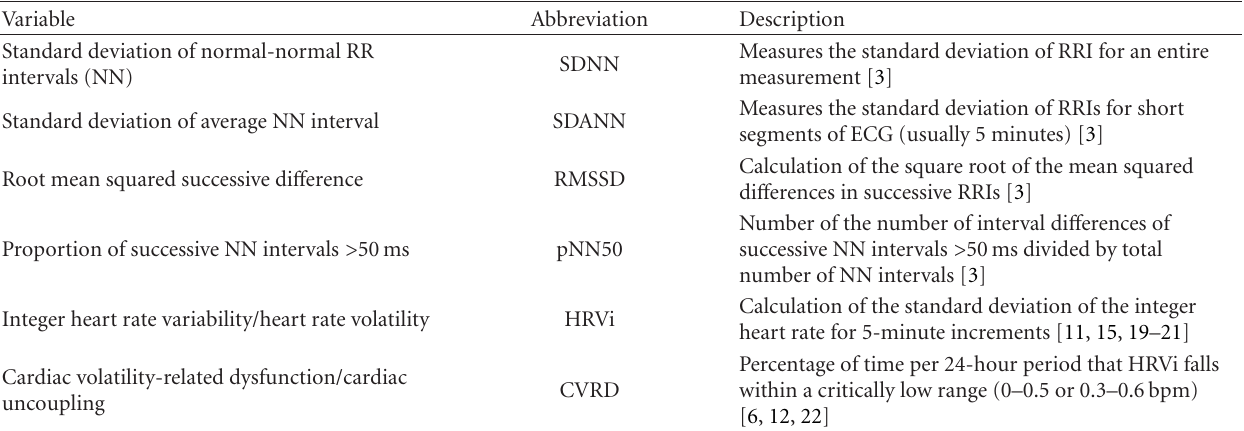
Table 1: Definitions of time-domain metrics of heart rate